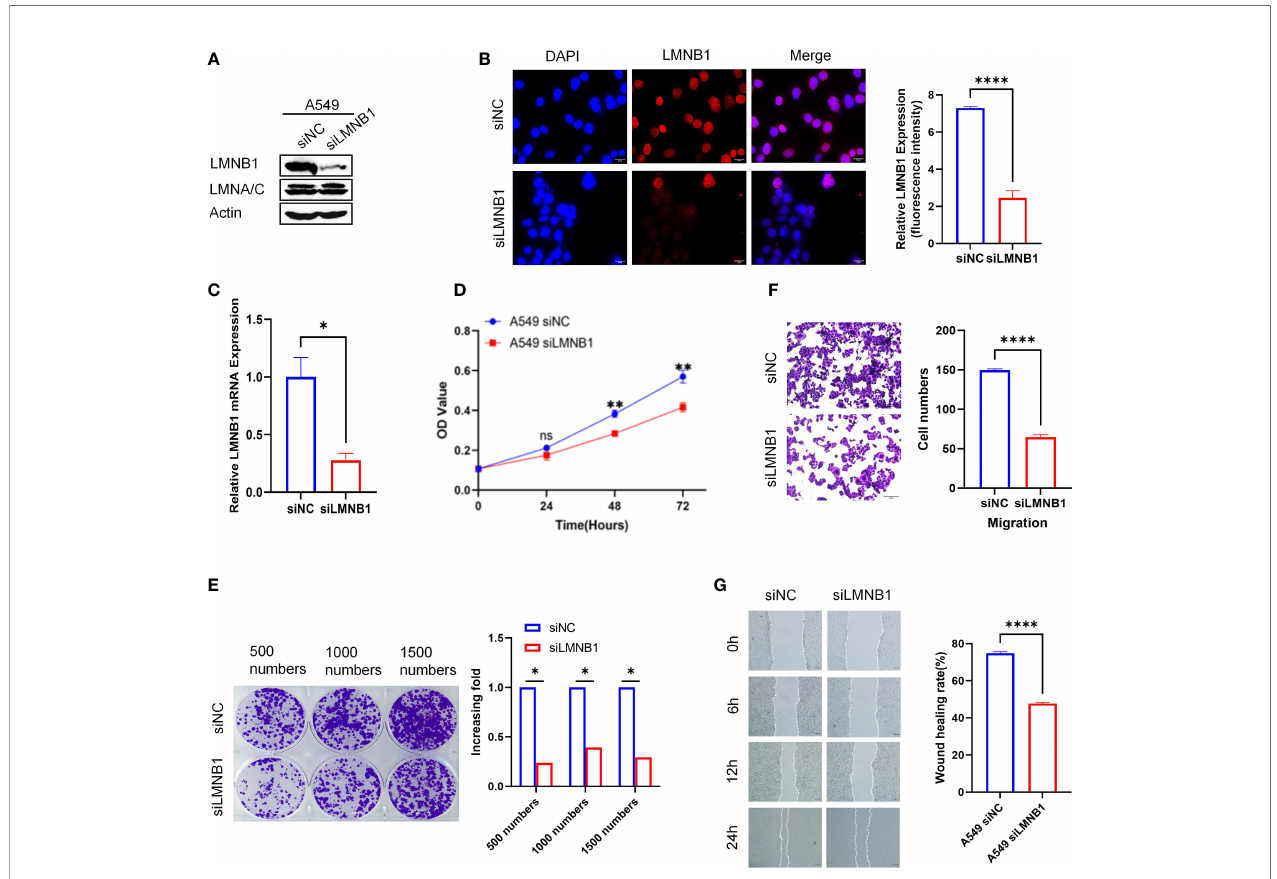
FIGURE 2 | LMNB1 knockdown inhibits LUAD cells proliferation. (A) A549 cells were transfected with LMNB1 siRNAs, and WB detected the expression of protein LMNB1. (B) Immuno fl uorescence was used to detect the expression of LMNB1 (red fl uorescence), and the relative fl uorescence intensity was quanti fi ed with Image J (P < 0.05), Scale bar, 20 m m. (C) RT-qPCR was used to detect the mRNA expression of LMNB1. (D) CCK8 assay was conducted to measure the growth of A549 siLMNB1 cells. The absorbance value was measured at 490 nm (**P < 0.01). (E) Colony formation assay was conducted to measure the proliferation of A549 cell lines after knockdown